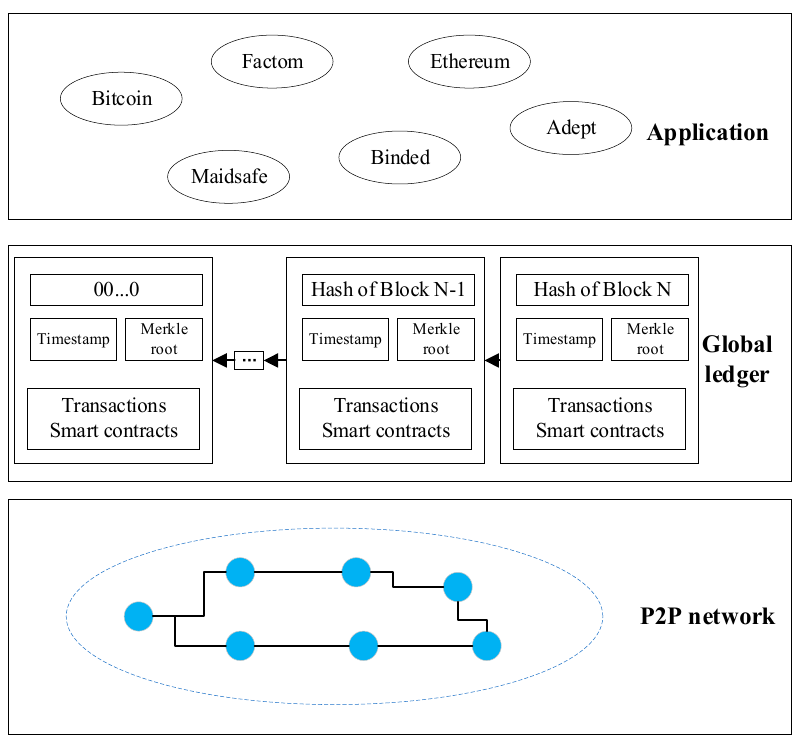
Figure 1 . The basic structure of blockchain. Figure 1. The basic structure of